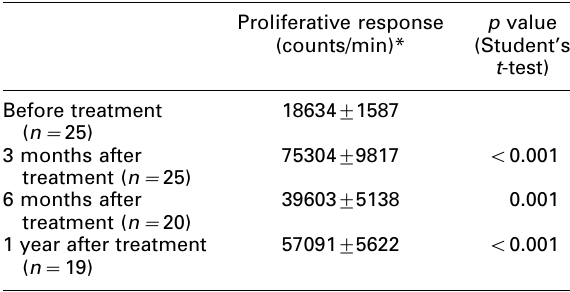
FIG. 3. Cytokine concentrations in the plasma during clari- thromycin treatment. Plasma samples were assayed for IL-4 (A) and IFN- g (B). Median values are indicated by the lines. Each dot represents one subject. A two-sample Wilcoxon test was used to compare the cytokine levels before treat- ment and 6 and 12 months after the start of therapy. Table 3. Effect of clarithromycin treatment on PHA-induced peripheral blood lymphocyte proliferation